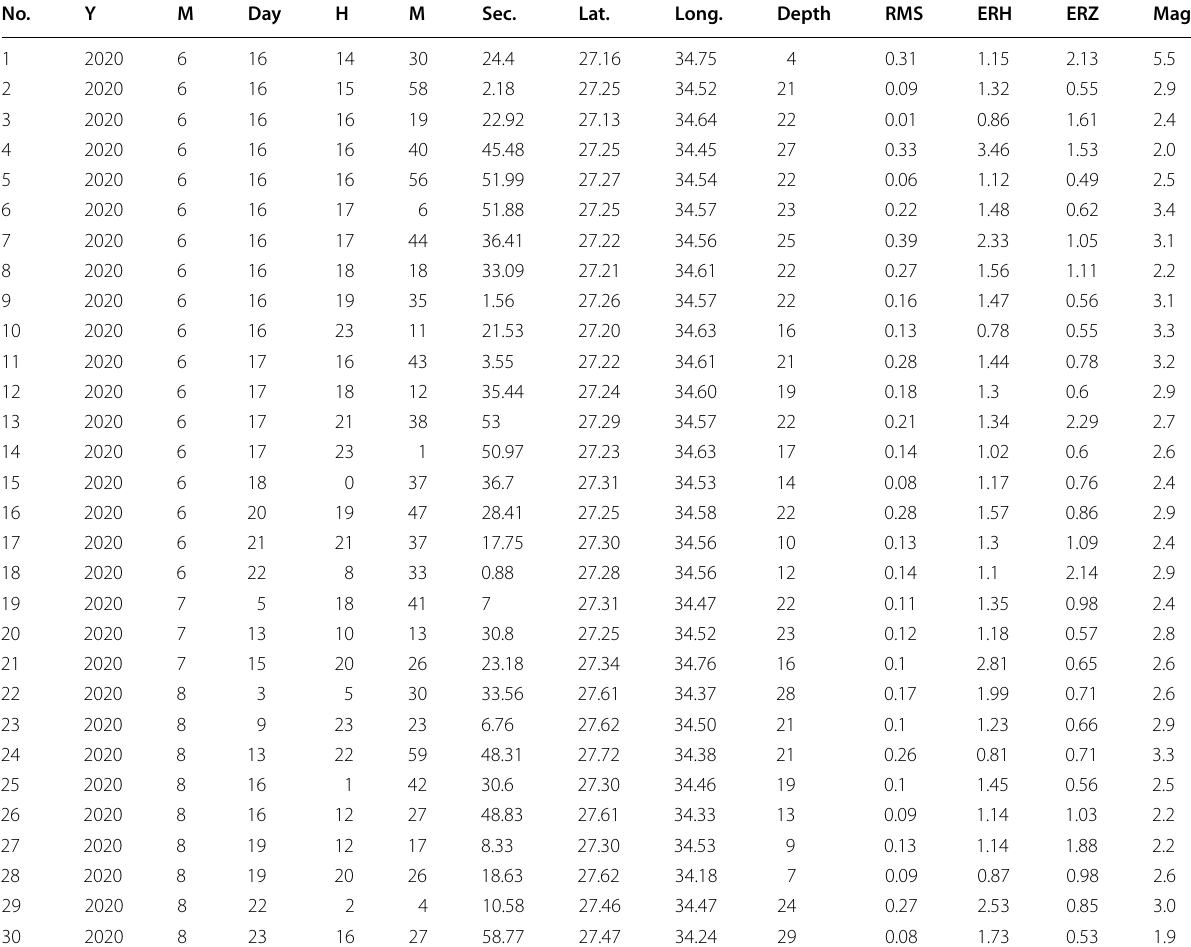
Table 1 The relocated origin parameters of the 16 Jun, 2020 earthquake and its significant aftershocks